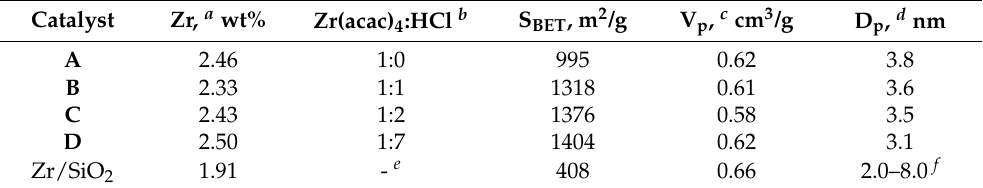
Table 1. Elemental analysis data and textural characteristics of Zr-silicates.